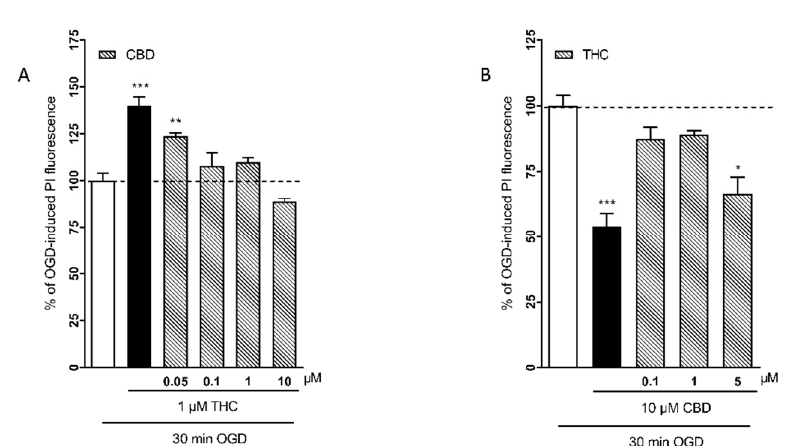
Figure 3. Effects of different combinations of THC and CBD concentrations in rat organotypic hippocampal slices exposed to OGD. ( A ): When the slices were incubated with the relative concentrations of CBD increased (0.1–10 µM), the neurotoxic effect of THC was lost. ( B ): The combination of 10 µM CBD with 5 µM THC was neuroprotective, but when the relative concentrations of THC were lower, the effect was lost. Bars represent the mean ± SEM of at least 5 experiments run in quadruplicate. * p < 0.05, ** p < 0.01 and *** p < 0.01 vs. OGD (one-way ANOVA plus Dunnett’s test).